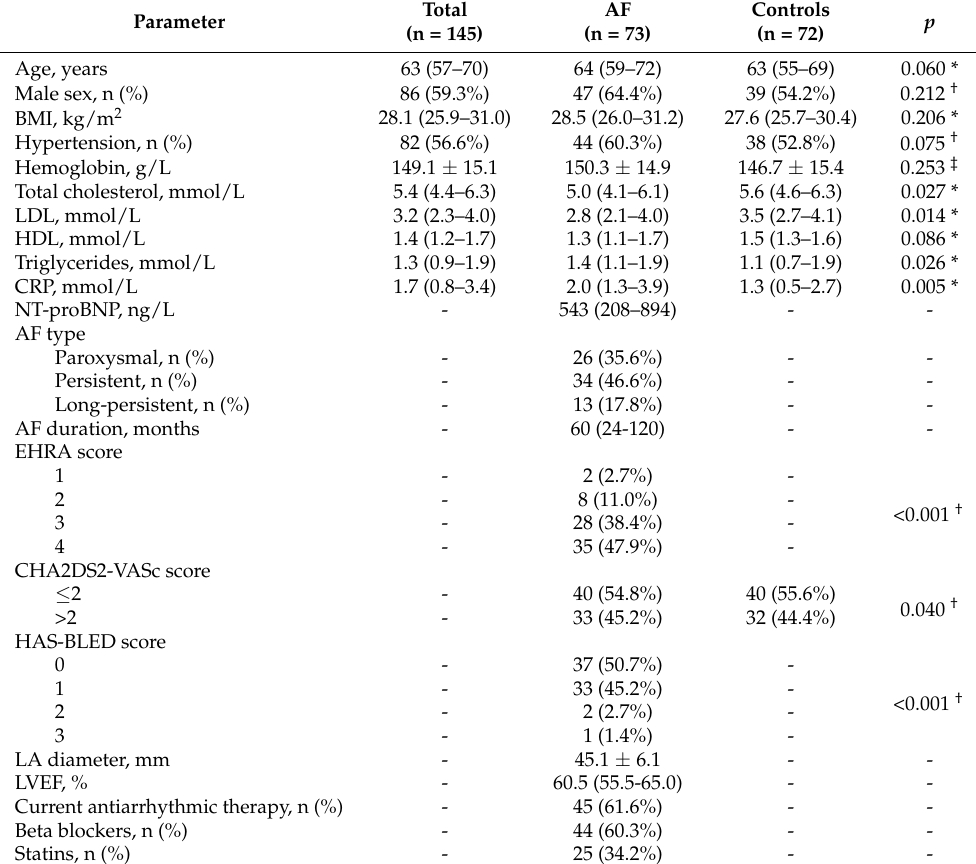
Table 1. Baseline characteristics of